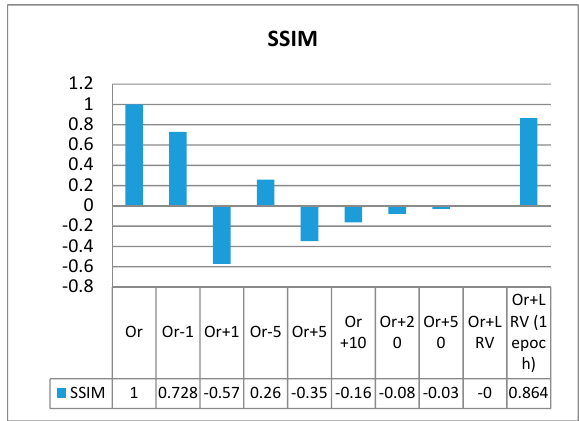
Figure 14. The effect of variation on SSIM. Figure 14. The e ff ect of variation on